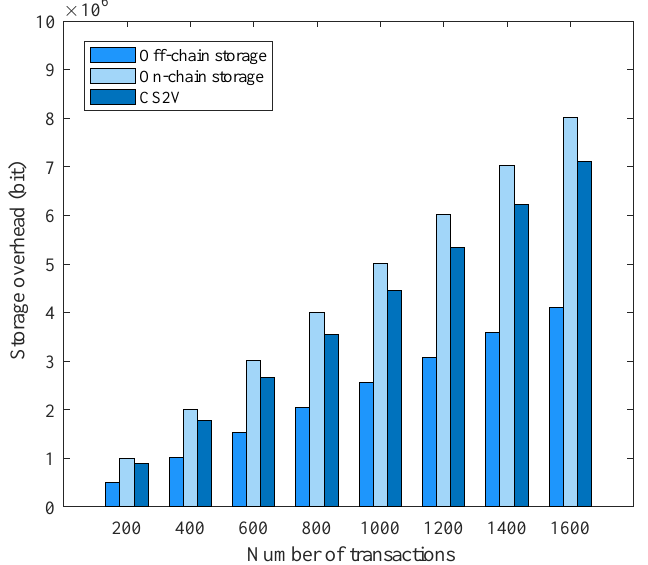
Figure 10. Storage overhead comparison with CS2V